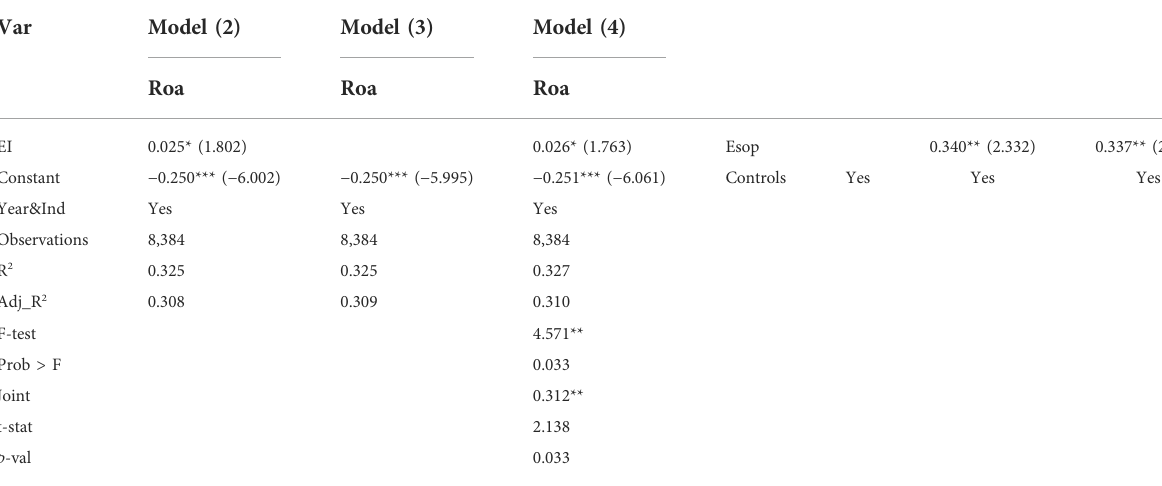
TABLE 4 Regression results of models (2) – (4).